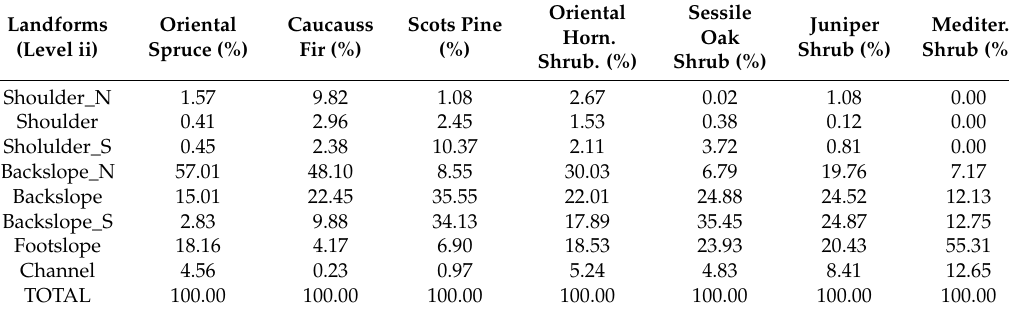
Table 3. Proportional distribution of landcover types relative to specific landform classes (level ii) expressed as a percentage